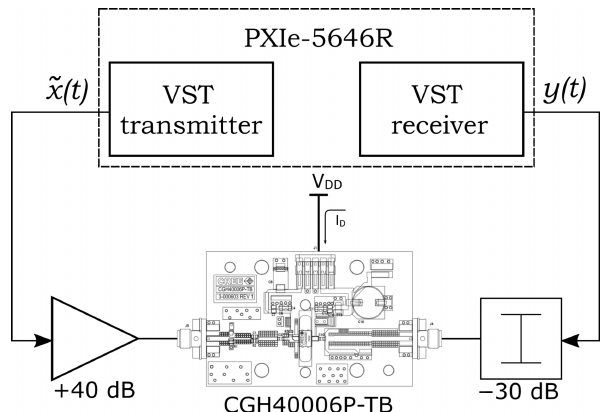
Figure 5. Measurement setup available at Chalmers University (RF WebLab) [29], used for the demonstration of the multi-objective linearization